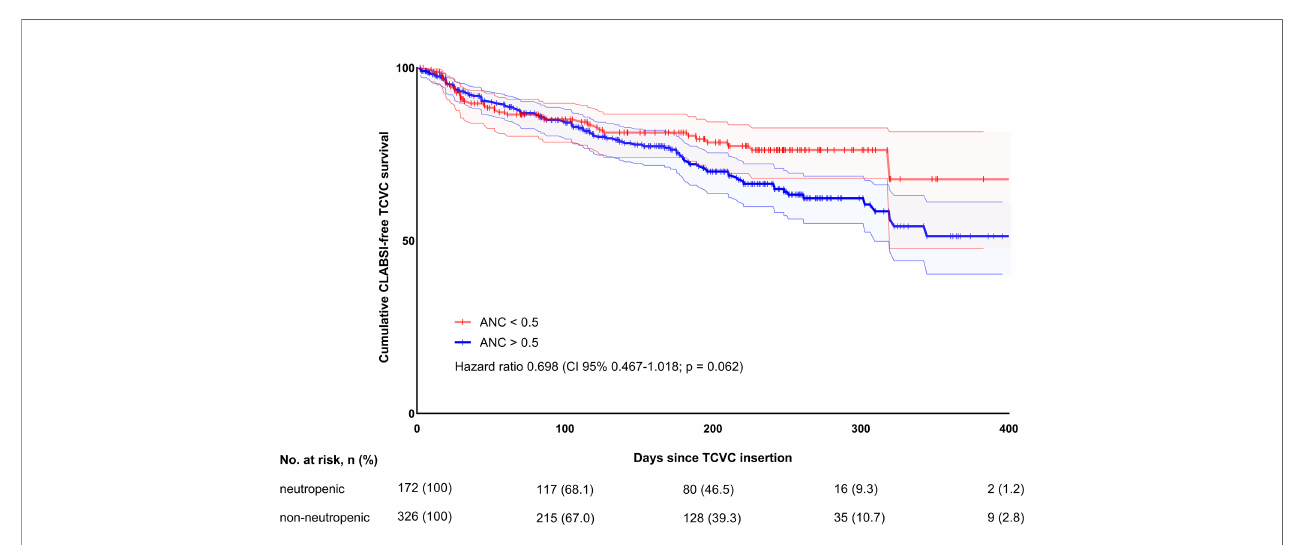
FIGURE 2 | Overall CLABSI-free TCVC survival in neutropenic and non-neutropenic patients.